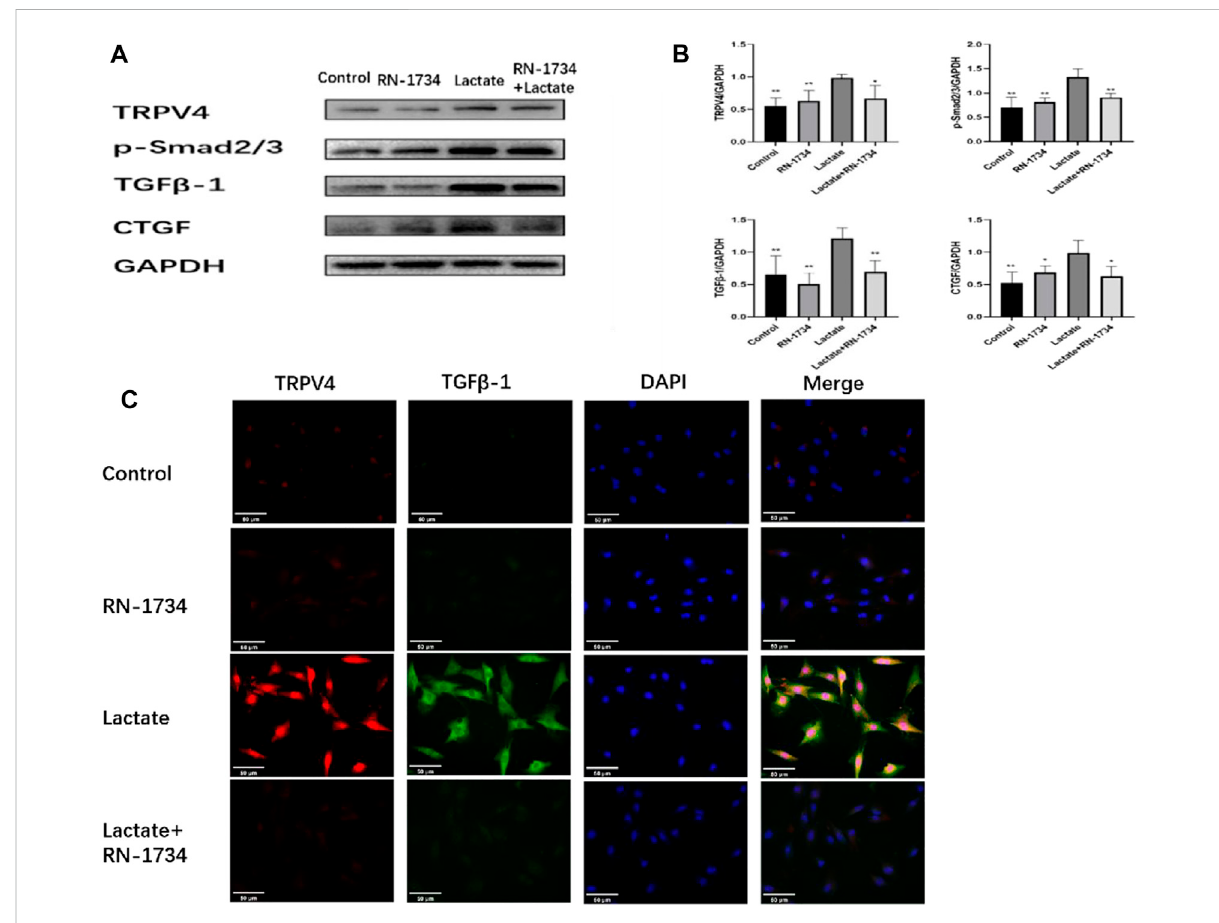
Effects of lactic acid on related fi brotic molecules in vitro . (A) Western blotting result and responding quanti fi cation of protein products of transient receptor potential vanilloid 4 (TRPV4), transforming growth factor-beta (TGF β -1), anti-Smad2 (phosphoT8) + Smad3 (phosphoT8) (p-Smad2/3), and connective tissue growth factor (CTGF) extracted from the rat kidney interstitial fi broblast (NRK-49F) cells. (B) Bars represent the corresponding protein quanti fi cation of TRPV4, TGF β -1, p-Smad2/3, and CTGF on the basis of GAPDH. Values are mean ± S.D. ( n = 5 in each group). $ p < 0.05 and $$ p < 0.01 versus the lactate group. (C) Immuno fl uorescence staining of responding protein products of transient receptor potential vanilloid 4 (TRPV4) and transforming growth factor-beta (TGF β